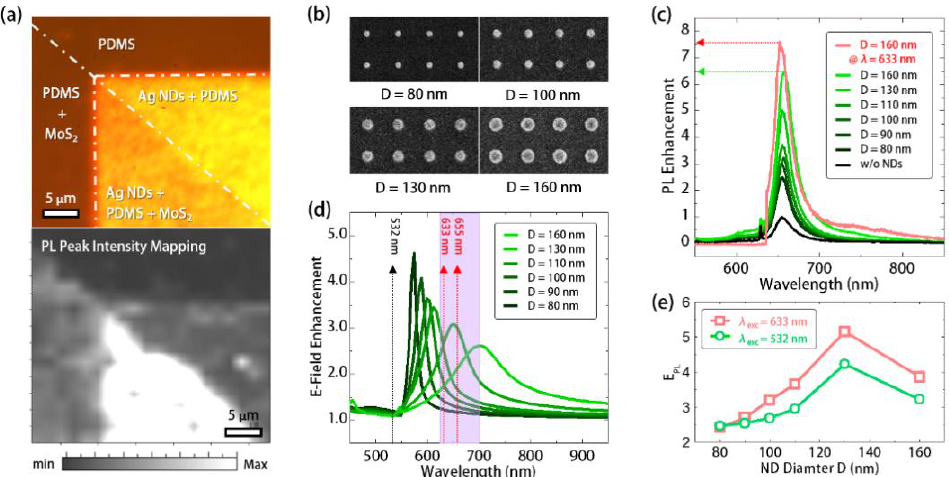
Figure 3. ( a ) (top) The OM image and (bottom) PL peak intensity mapping ( λ em = 655 nm) of sample areas with different material combinations; ( b ) the SEM images of silver ND arrays with D from 80 to 160 nm; ( c ) the measured PL spectra of MoS 2 covering these silver ND arrays in PDMS. The PL spectrum of MoS 2 with silver ND array with D = 160 nm under a 633 nm laser excitation is also in the same plot; ( d ) theoretical enhancement of electrical field of SLR modes within MoS 2 in silver ND arrays under different D values and wavelengths; ( e ) the calculated E PL contributed by SLR modes in silver ND arrays with different D values under λ exc of 532 and 633 nm.